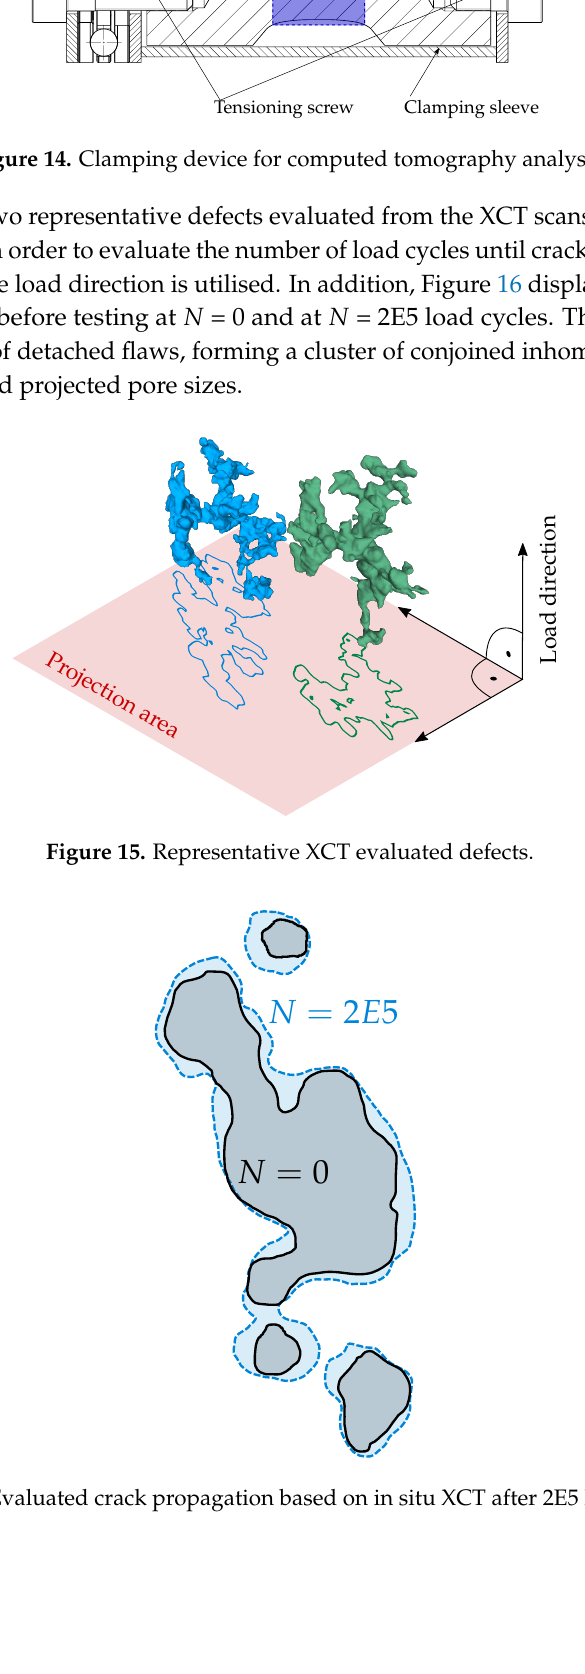
Figure 14. Clamping device for computed tomography analysis